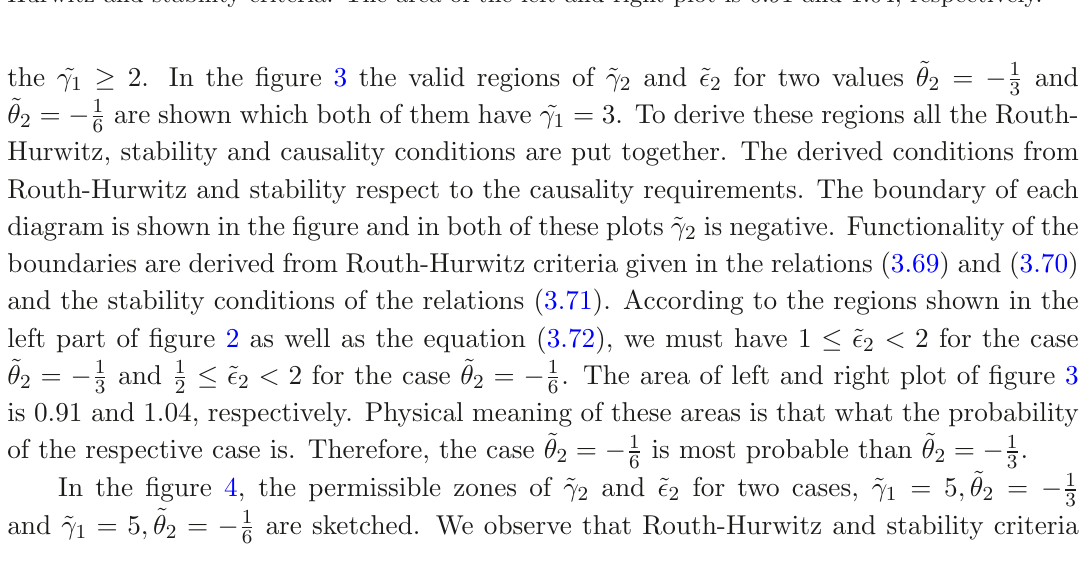
Figure 3 . Phase space of transports ˜ γ 2 and ˜ ǫ 2 . Both of these plots have ˜ γ 2 with the second law of thermodynamics. Functionality of boundaries are derived from Routh- Hurwitz and stability criteria. The area of the left and right plot is 0.91 and 1.04,